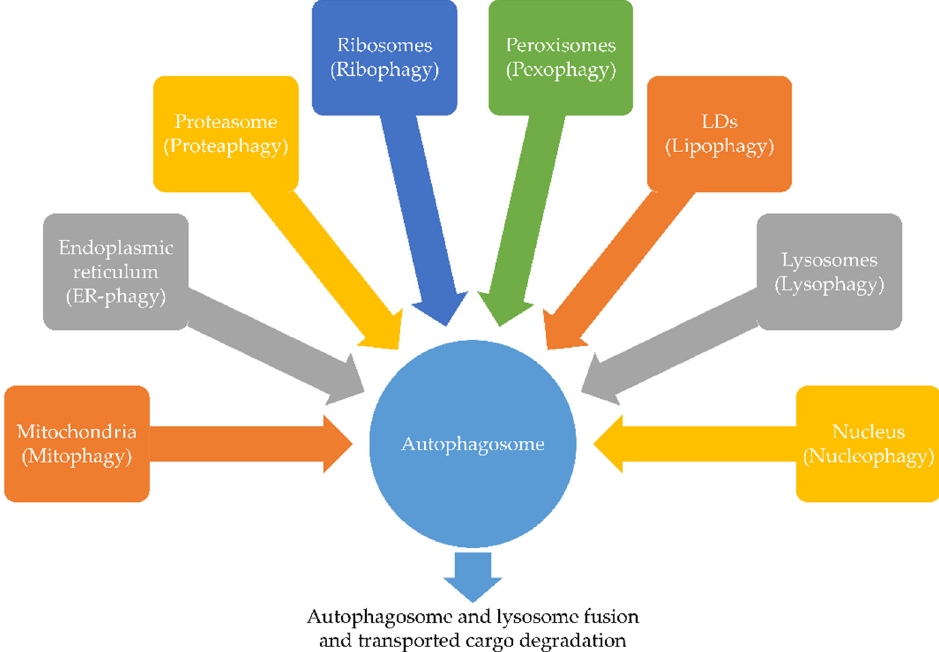
Figure 2. Selective forms of autophagy. Depending on the degraded organelle we can distinguish: mitophagy, ER-phagy, proteaphagy, ribophagy, pexophagy, lipophagy, lysophagy and nucleophagy.